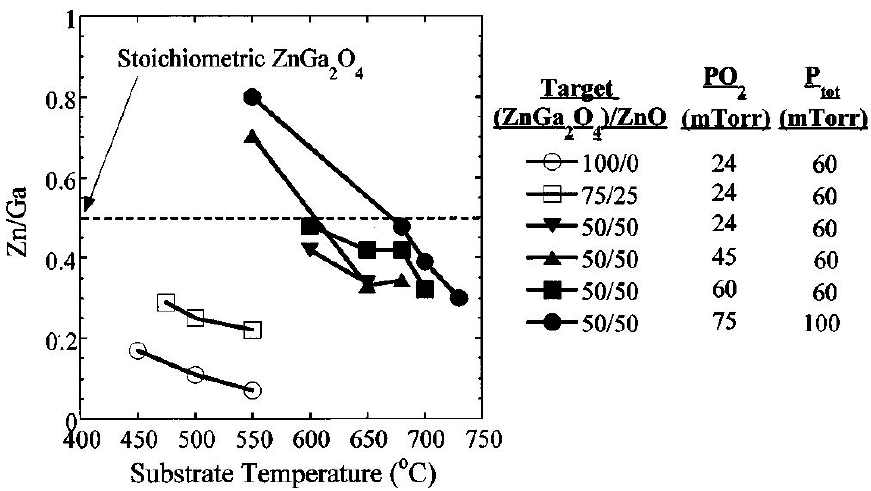
Figure 12. Variation of Zn/Ga ratio in ZnGa 2 O 4 films with various types of ZnGa 2 O 4 /ZnO targets and substrate temperatures [79] (with copyright permission from AIP Publishing, 2020).